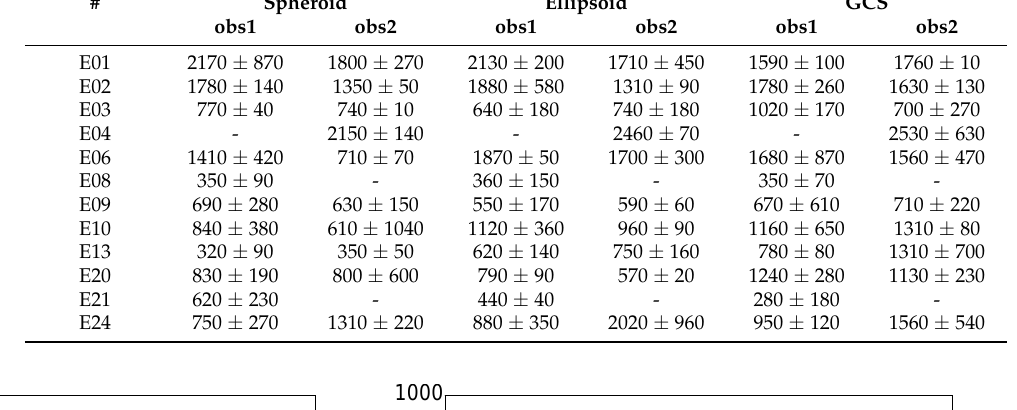
Table 3. Three-dimensional de-projected values of CME speed, in kms − 1 , averaged from the individ- ual fits for observers (’obs’) 1 and 2. The event labels (in col. 1) are as in Table 1. Spheroid